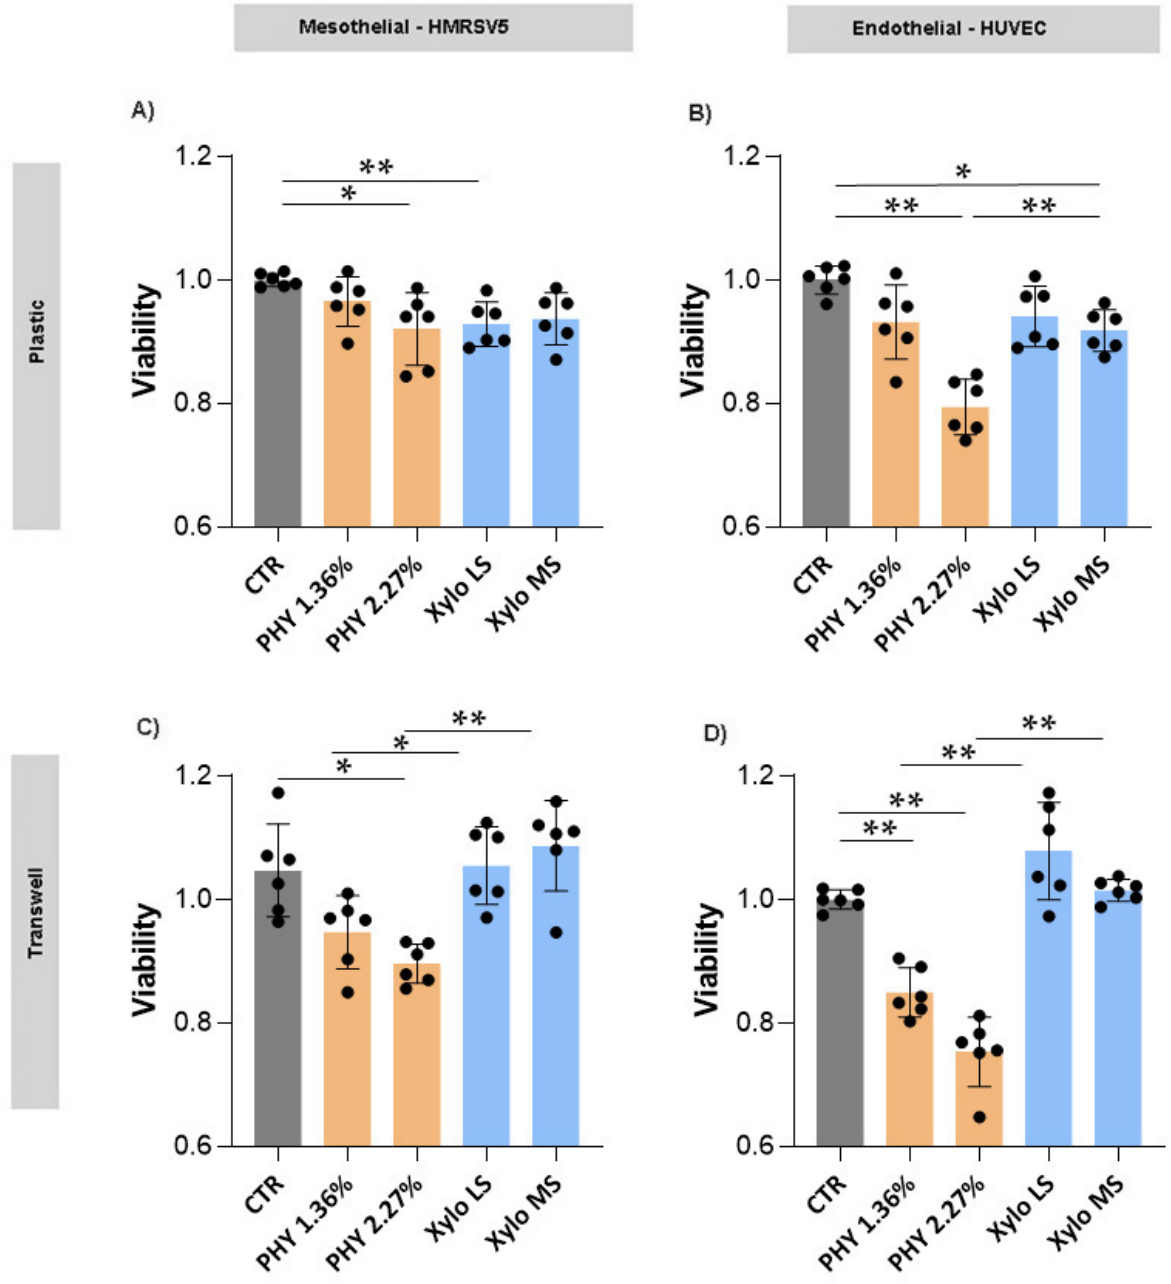
Figure 1. Cells viability. Cell viability was assessed with the MTS assay in mesothelial ( A , C ) and endothelial ( B , D ) cells cultured in plastic ( A , B ) or transwell ( C , D ) with or without different PD solutions. Graphs represent mean ± standard deviation (error bars) ( n = 6 biological replicates). ( A ) CTR vs. PHY 2.27% p = 0.0148, CTR vs. Xylo LS p = 0.0337; ( B ) CTR vs. PHY 2.27% p < 0.0001, CTR vs. Xylo MS p = 0.0208, PHY 2.27% vs. Xylo MS p = 0.0003; ( C ) CTR vs. PHY 2.27% p = 0.0018, PHY 1.36% vs. Xylo LS p = 0.0363, PHY 2.27% vs. Xylo MS p = 0.0001; ( D ) CTR vs. PHY 1.36% p < 0.0001, CTR vs. PHY 2.27% p < 0.0001, PHY 1.36% vs. Xylo LS p < 0.0001, PHY 2.27% vs. Xylo MS p < 0.0001 * p < 0.05, ** p < 0.001.